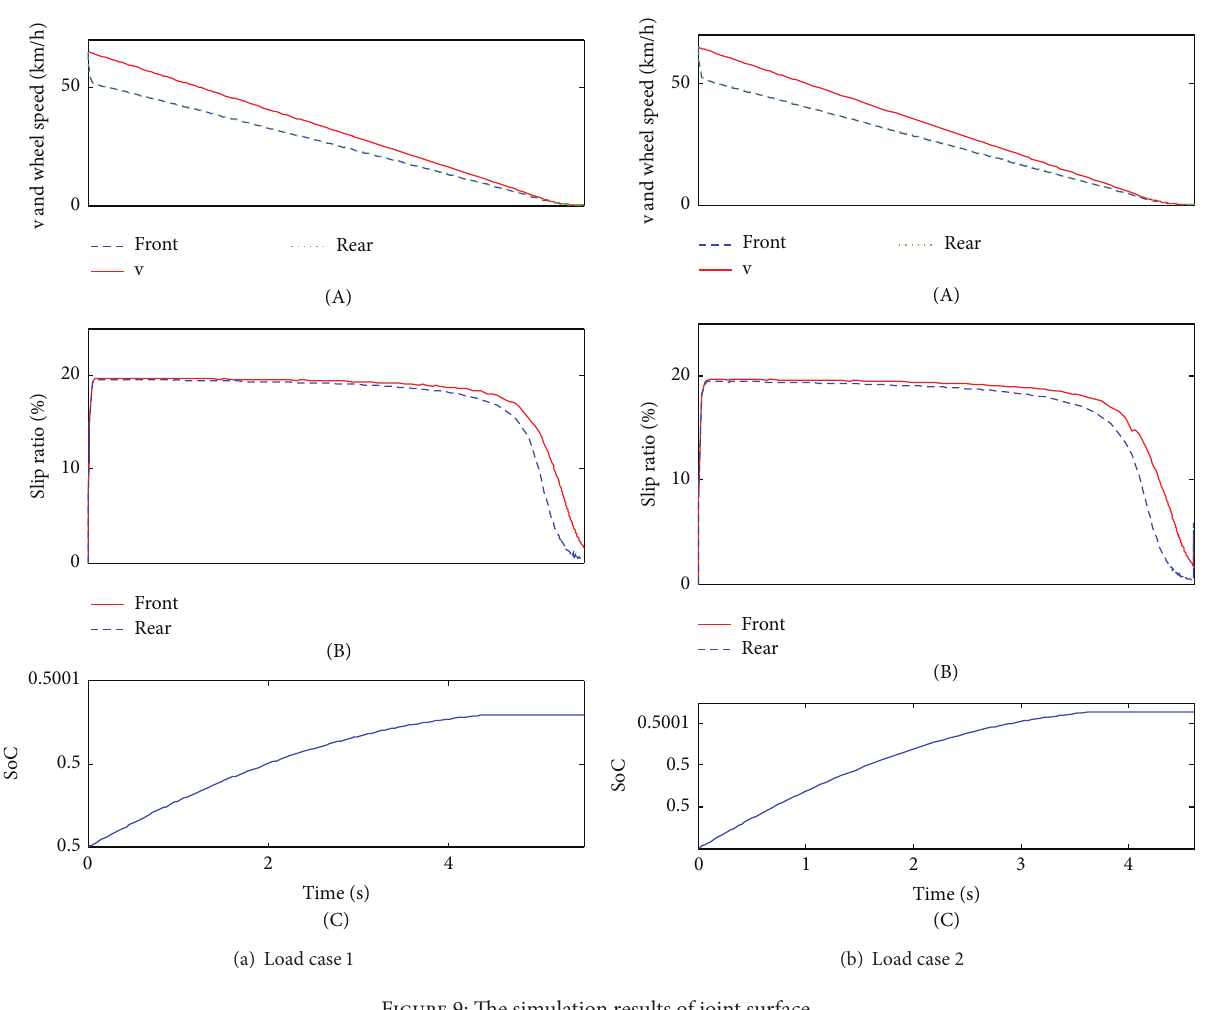
Figure 9: The simulation results of joint surface.